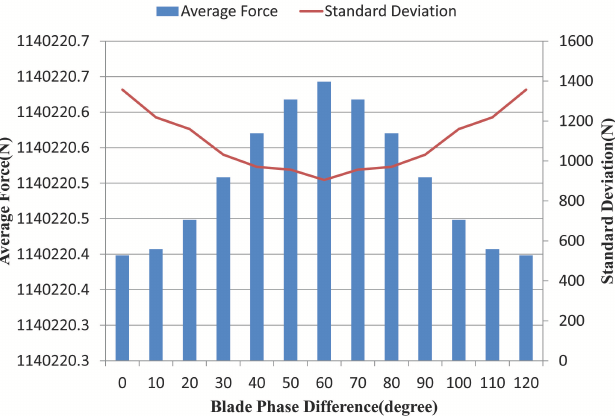
Figure 15. The average turbine loads and their standard deviation vs. the phase angle